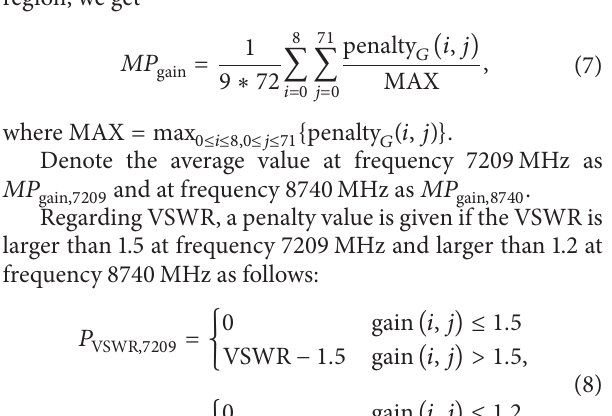
Table 7: Comparison of VSWR between the roughly evolved antenna and the orthogonally designed one.